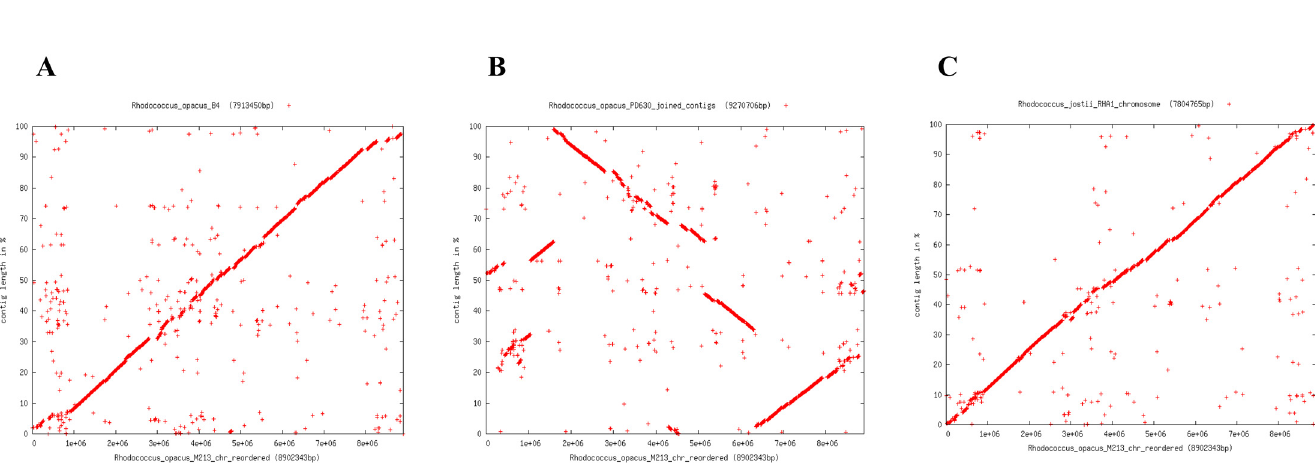
Fig 3. Whole genome-based synteny dot plots generated between R . opacus strain M213 and R . opacus strain B4 (A); strain M213 and R . opacus strain PD630 (B); strain M213 and R . jostii strain RHA1 chromosome (C), respectively.